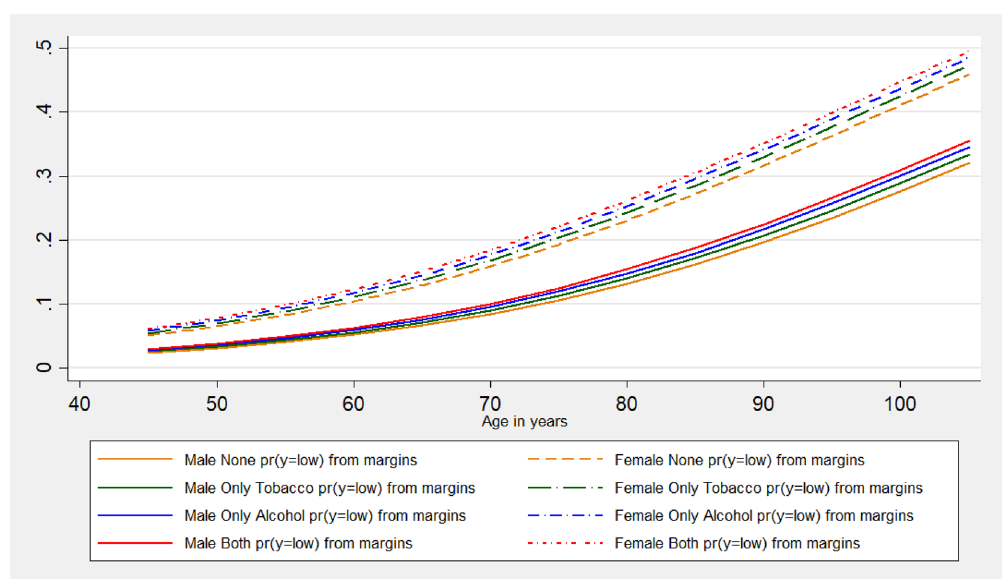
Figure 5. The gender pattern of average marginal effects of age on low cognition by substance use among older adults, LASI, Wave 1,